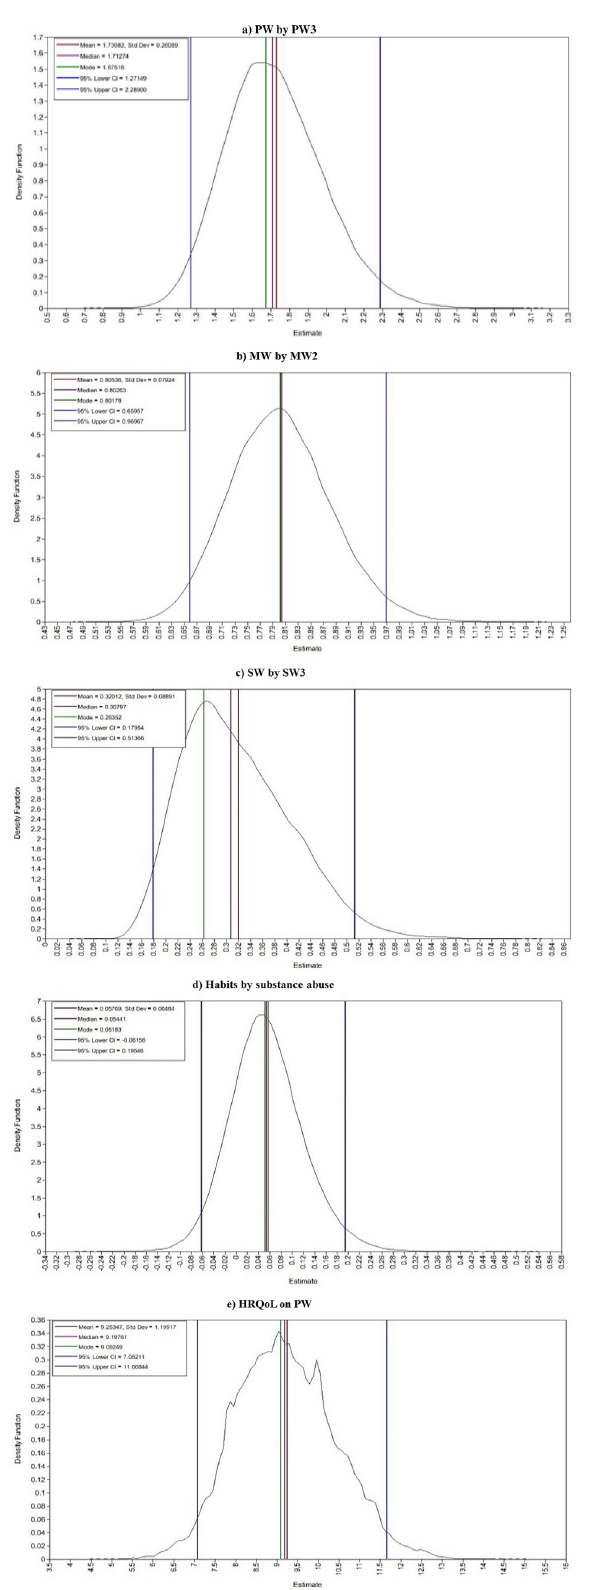
Fig 3. Posterior distribution of kernel